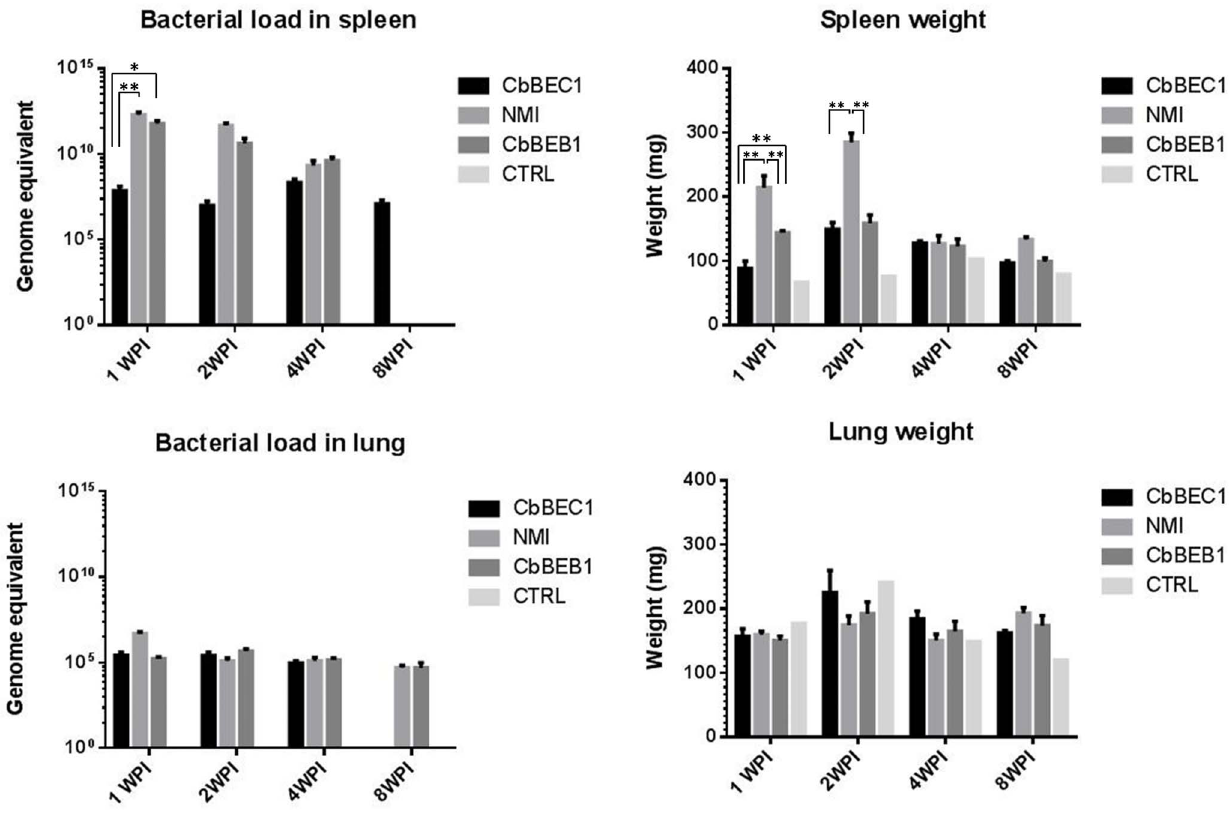
with NMI, CbBEB1 and CbBEC1 at 1, 2, 4 and 8 weeks post infection. Mean values + / 2 Standard Error (SE) for 5 mice are shown. * indicates p-values smaller than 0.05 ** indicates p-values smaller than 0.01.